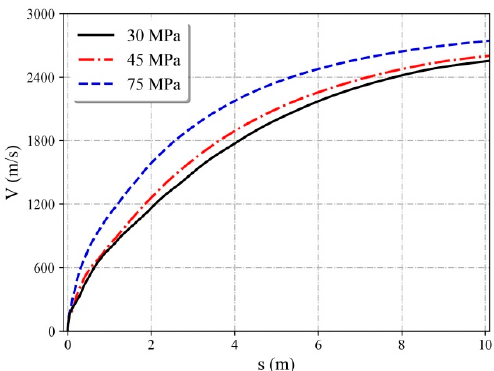
Figure 12. Simulated projectile velocities versus projectile travel distance for different rupture pressure values of diaphragm Ⅱ .